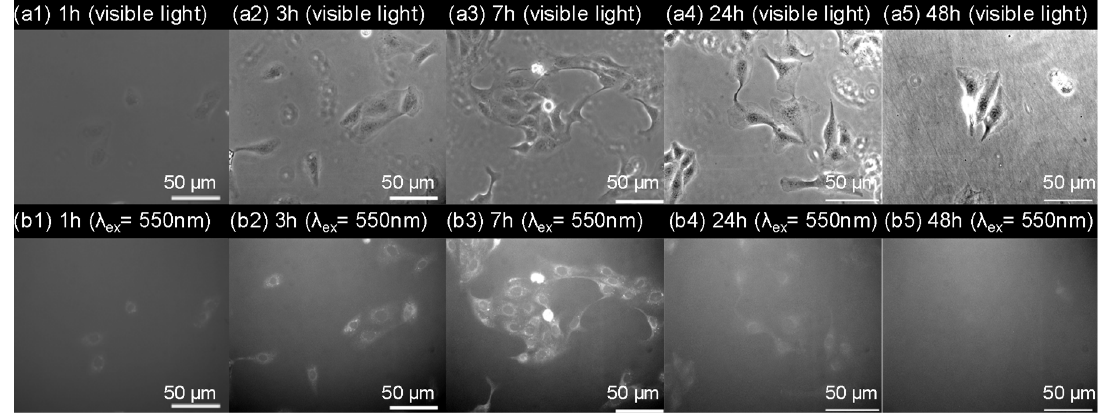
Figure 7. ( a ) Bright field and ( b ) fluorescent images (λ ex = 550 and λ em = 630 nm) of Madin-Darby Canine Kidney (MDCK) cells in the presence of Nile red-containing PVBPA 34 - g -PNVP 60 micelles.